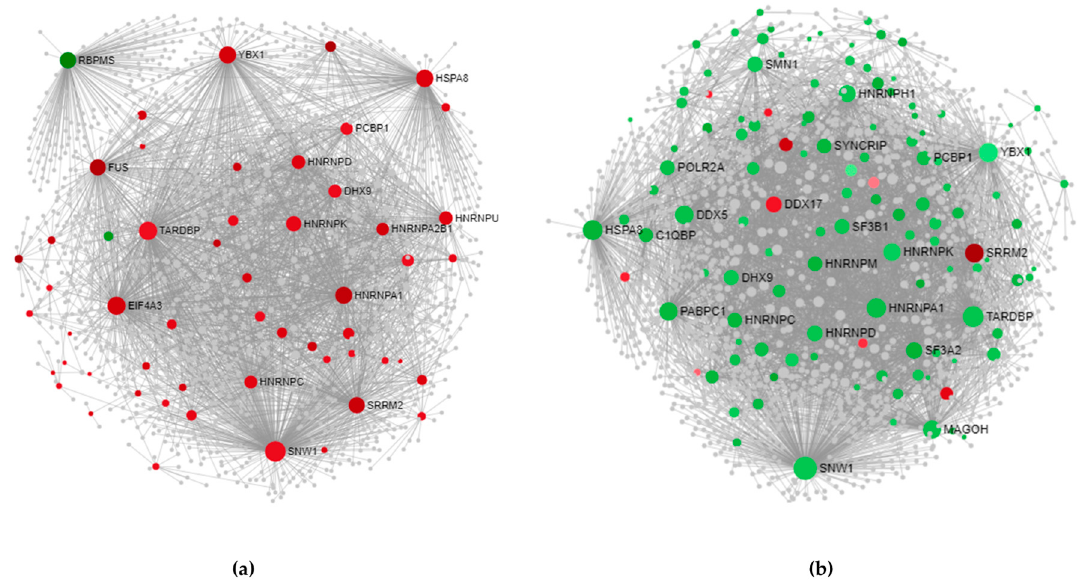
Figure 5. PPI networks in ( a ) SALS1 and ( b ) SALS2 cortexes. To better visualize the generated networks we used the Force Atlas layout algorithm. Sphere size is proportional to the degree of connection, whereas the color (red for up-regulated and green for down-regulated in SALS subtypes) represents the expression logFC value. Details about nodes properties are listed in Supplementary Data